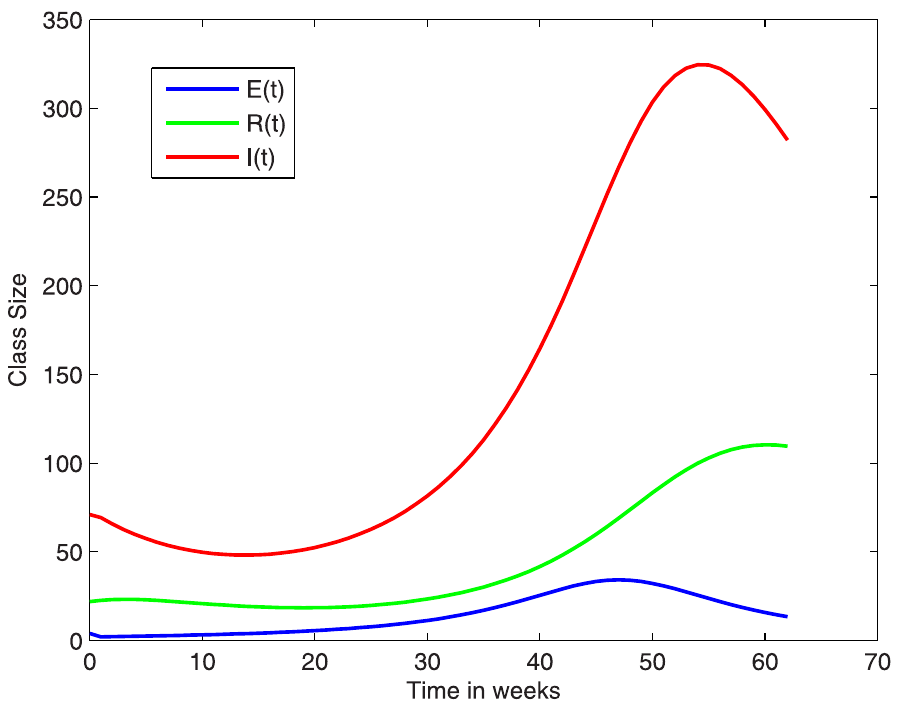
Fig 5. Trajectories of the E, I and R -classes over the outbreak period, using the density plot.